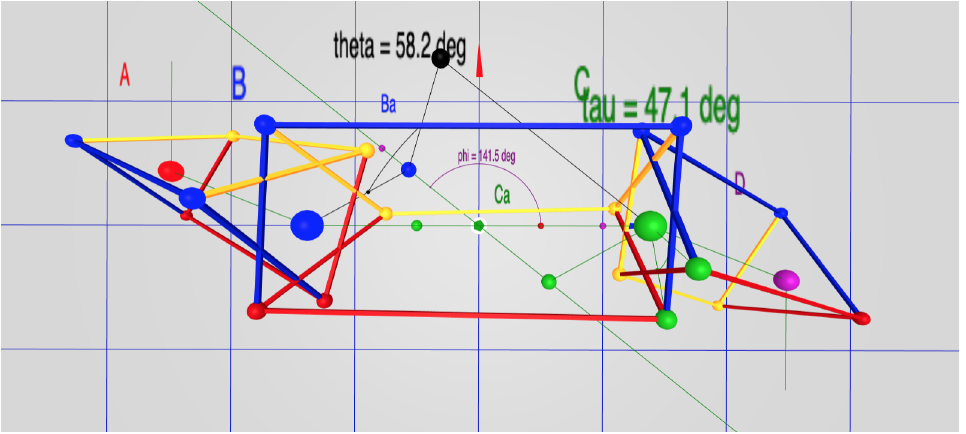
Figure 6. A Balanced